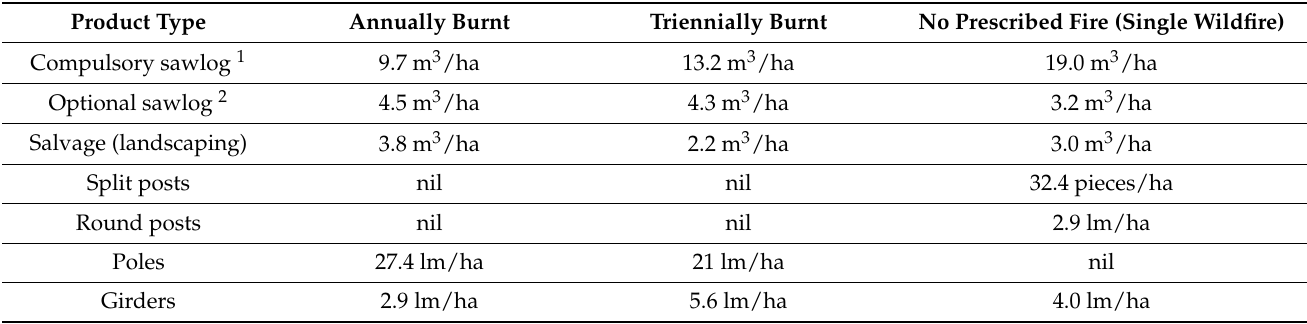
Table 1. Products removed on a per hectare basis (volumes in m 3 , total length in linear metres (lm) and number of pieces) from triennially burnt, annually burnt and no prescribed fire treatments during harvest operations in